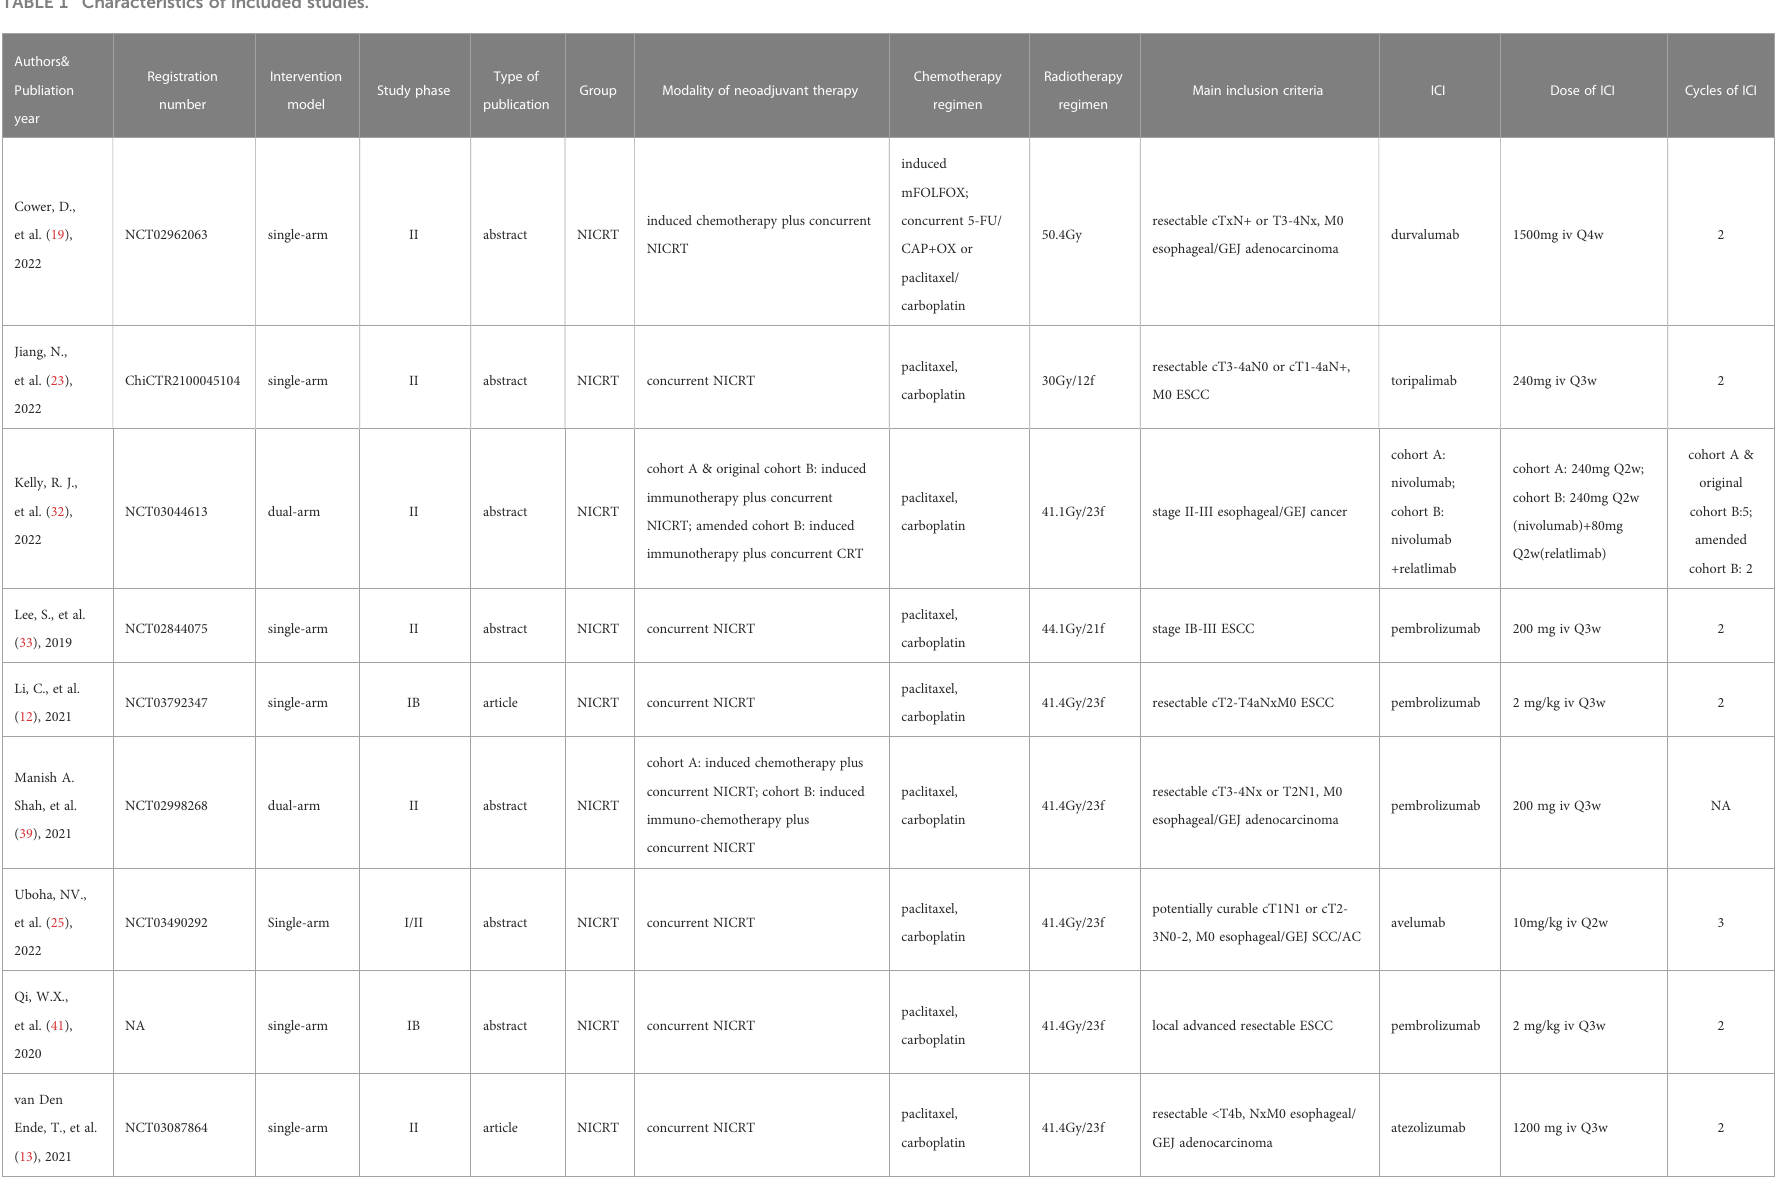
TABLE 1 Characteristics of included